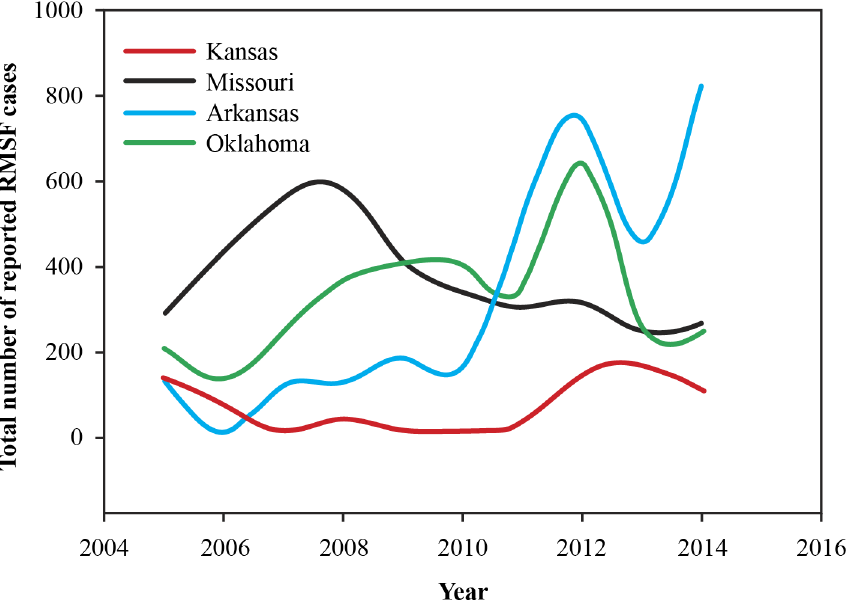
Fig 1. Plot of reported number of cases submitted to different state health departments in the study